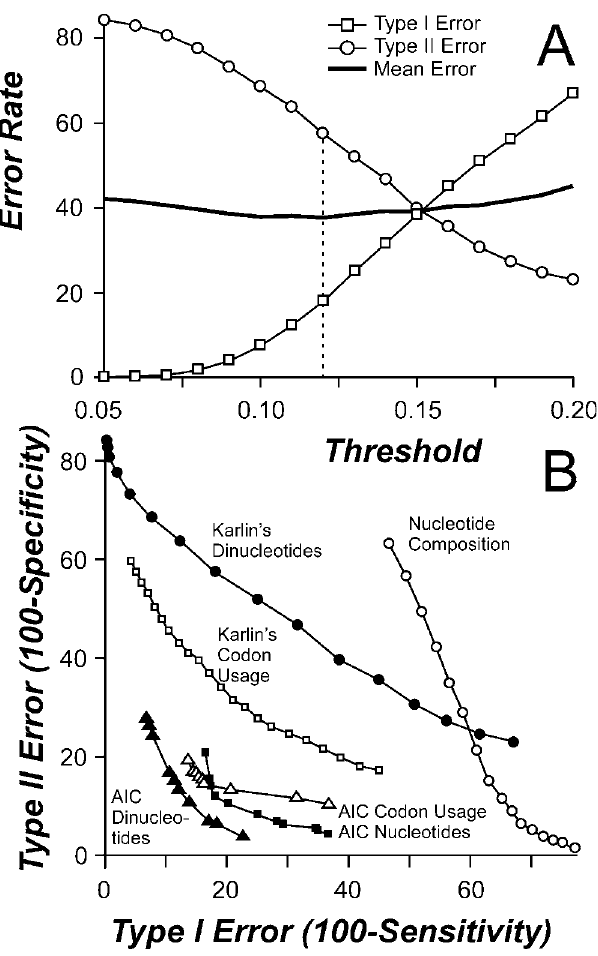
Figure 5. Tradeoffs in Error Rates in Methods for Detecting Atypical Genes (A) Type I error, type II error, and mean error for predicting foreign genes according to Karlin’s DNC method [32]; the dashed line indicates the minimum mean error. (B) Tradeoffs in error rates for several methods of gene